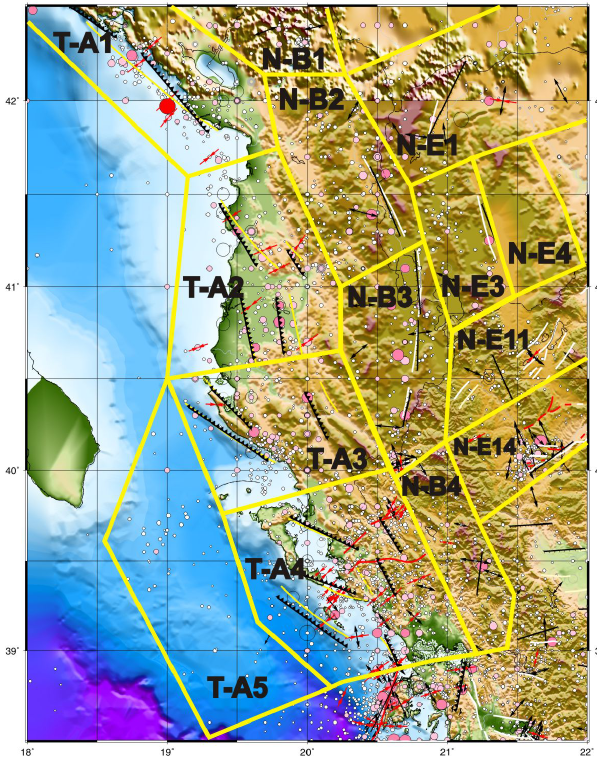
Figure 6. A typical example of seismic zone separation for the re- gion of Albania, Northwest Greece, South Montenegro and West FYROM. All available data of seismic and geological faults, stress axes, and earthquake epicentres are combined into a single map. Yellow frames depict the new seismic zone boundaries derived from this